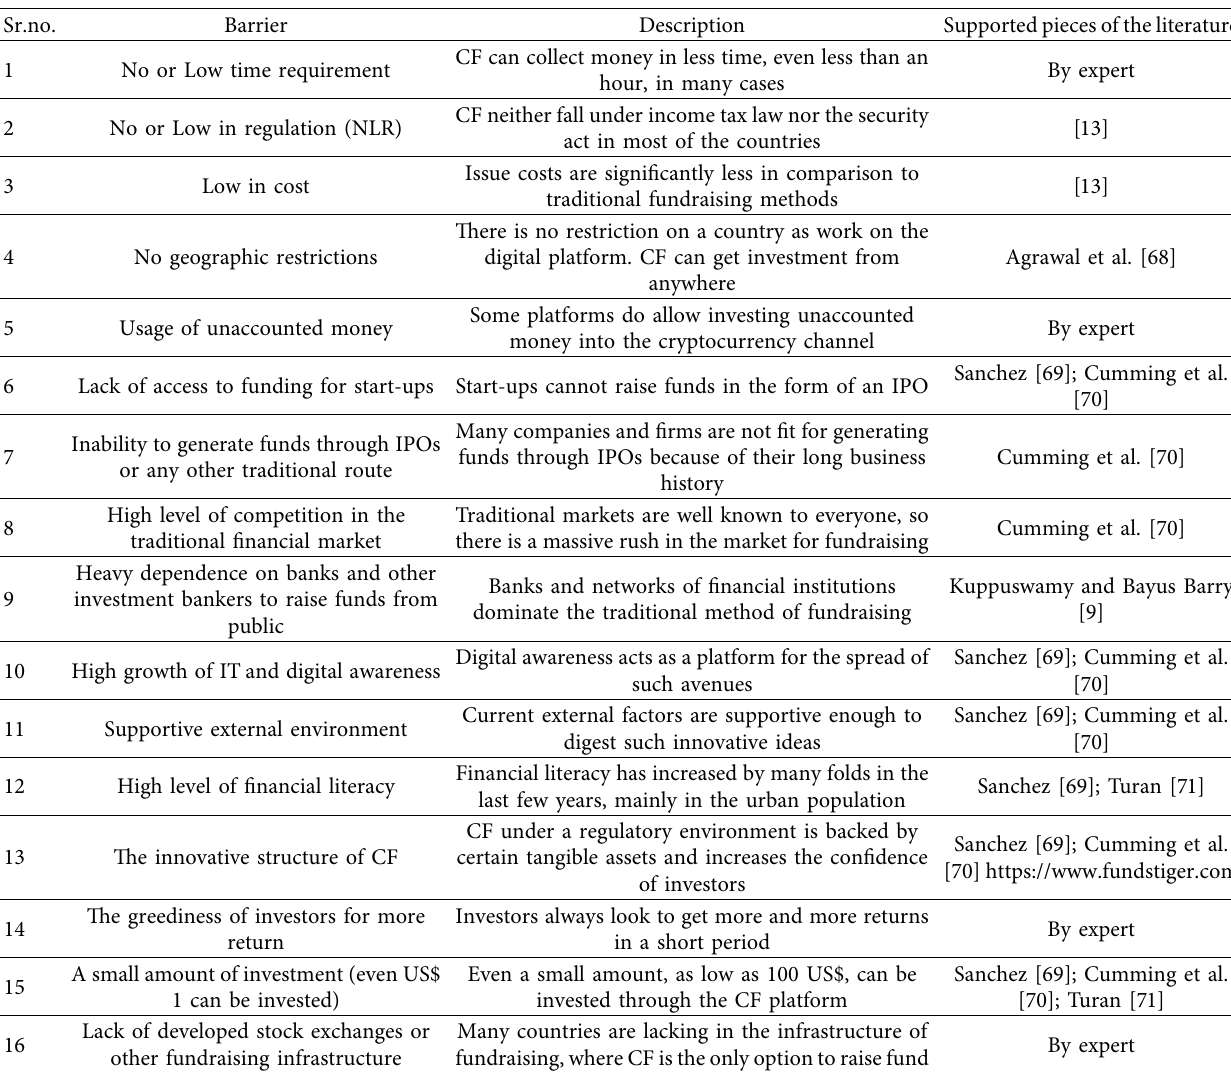
Table 1: Description of CF